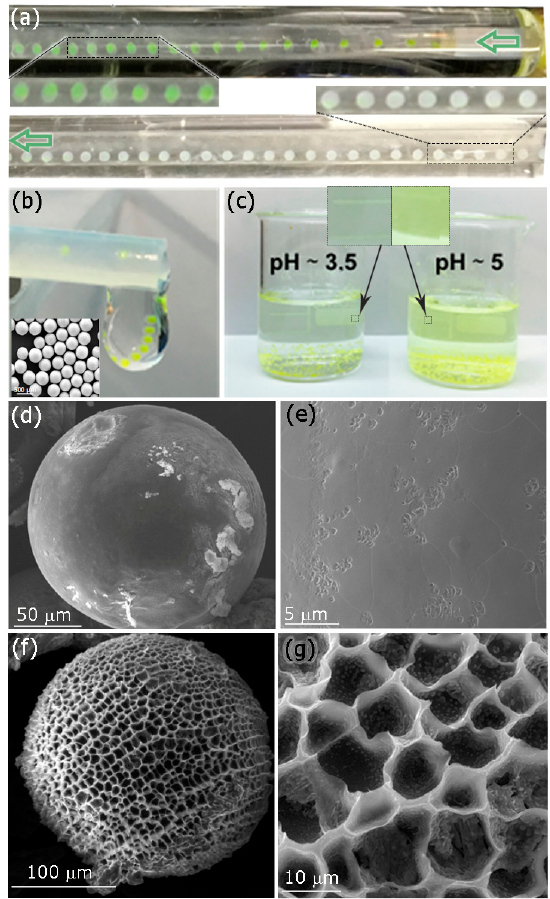
Figure 3. ( a ) Droplets of double emulsion formed at the tip of the coaxial capillaries when the pH of the continuous phase was 6.5 (yellowish) and at the outlet (white); insets depict the drops’ hue at the tip of the capillaries and at the outlet. ( b ) Double emulsion drops stabilized at the outlet of the microfluidic system when the pH of the continuous phase was 3.5. Inset represents a SEM image of produced MPs. Scale bar is 500 μ m. ( c ) Comparison of the enteric microparticles formed after the evaporation of the solvent at different pHs (3.5 and 5). Q i/ Q m /Q o = 2/10/200 μ L/min at room temperature. The insets show the solution hue. Cryo-SEM images of MPs at different pHs after 24 h incubation: ( d , e ) pH = 3.5 and ( f , g ) pH = 5.